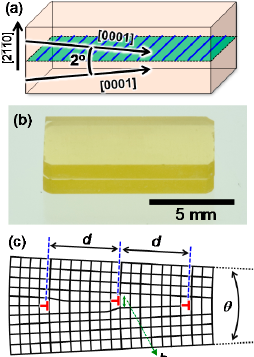
Figure 2. Schematics and optical micrograph of the fabricated ZnO bicrystal with a (21 (cid:3364) 1 (cid:3364) 0)/[011 (cid:3364) 0] 2° tilt grain boundary. ( a ) Schematic illustration showing the crystallographic orientations of two pieces of used ZnO single-crystal plates. ( b ) A fabricated ZnO bicrystal. ( c ) Schematic illustration showing periodic dislocations at the boundary.